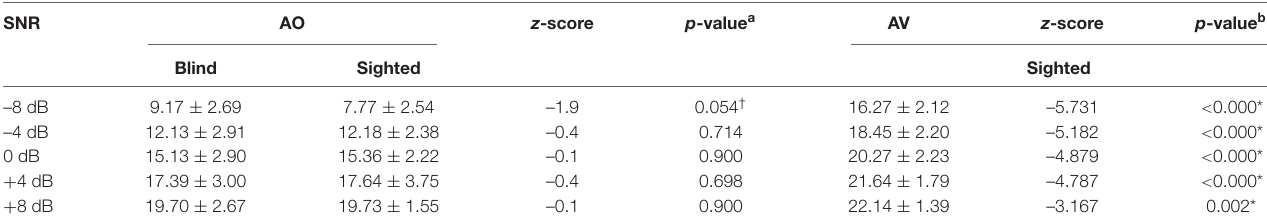
a Comparison between blind and sighted subjects, † Near-significant difference. b Multiple comparisons among the AO condition in blind subjects, the AO condition in sighted subjects, and the AV condition in sighted subjects, *p < 0.003 (Bonferroni’s corrected α = 0.05/15 =